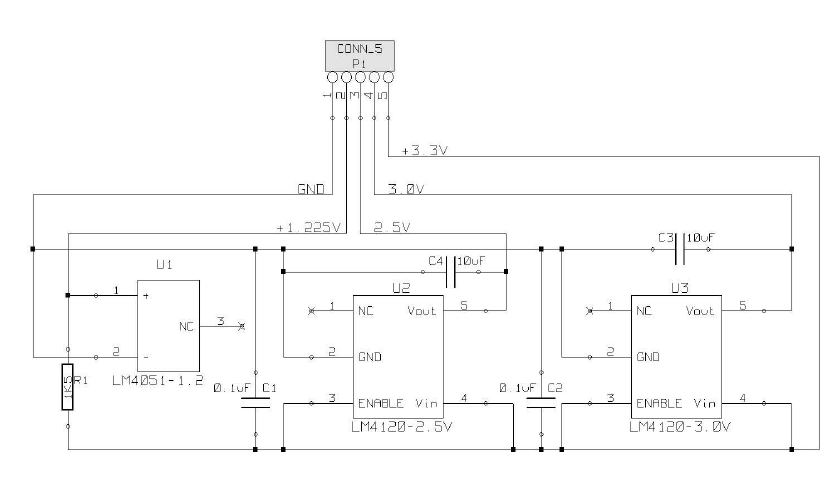
Figure 4. Circuit schematic of the voltage